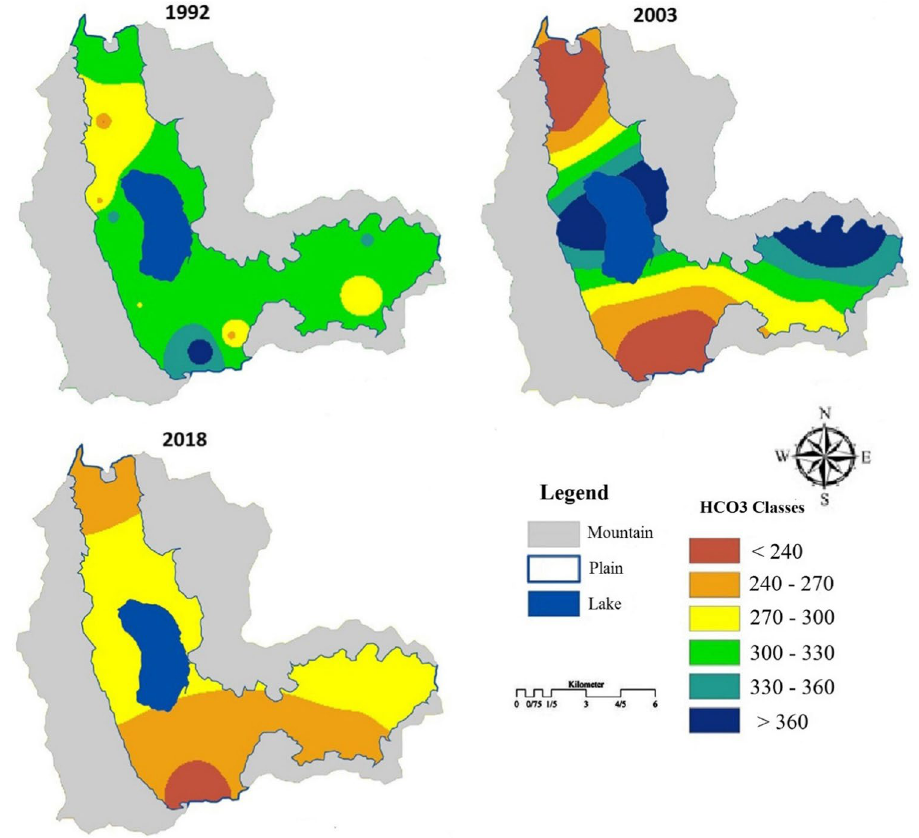
Fig. 8 Spatial variations